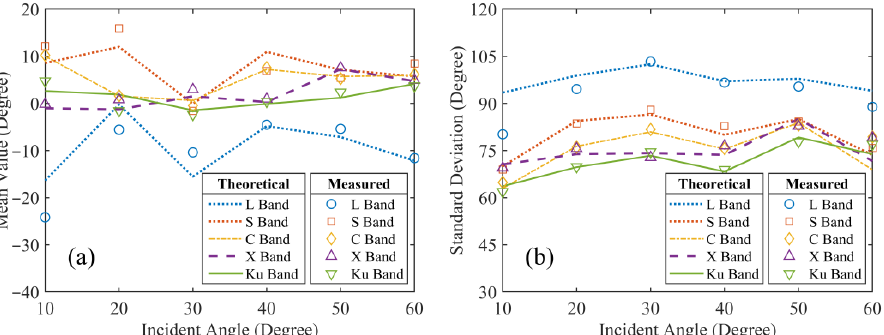
Figure 12. Angular variations of the ( a ) mean and ( b ) standard deviation of the co-pol phase differ- ence.